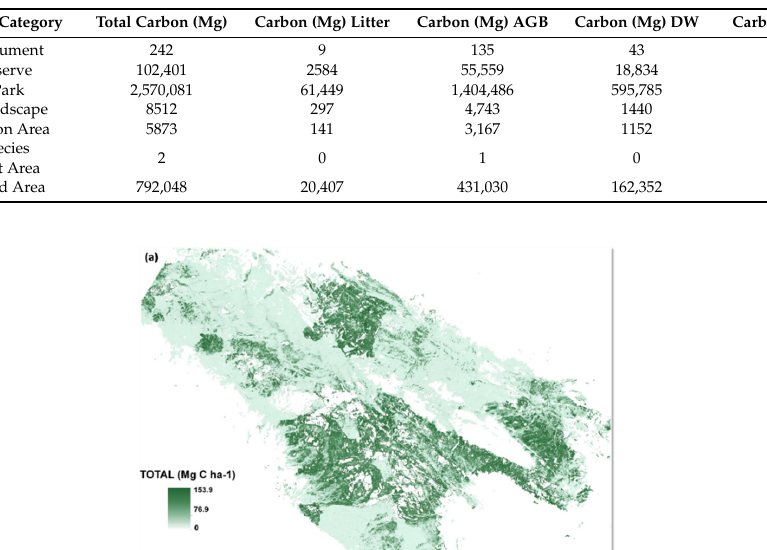
Table 8. Results of degraded carbon for different pools per protected area category.